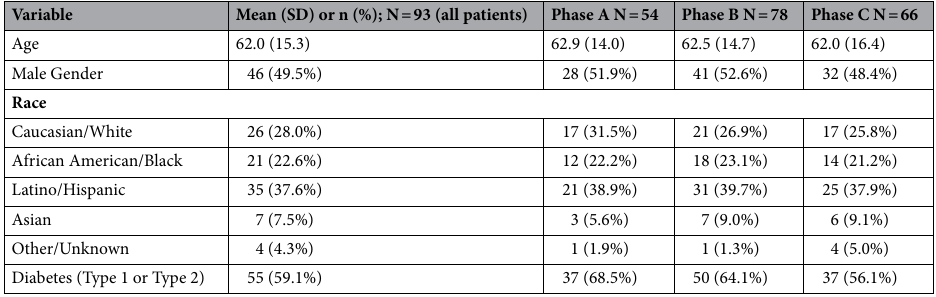
Table 1. Patient characteristics.